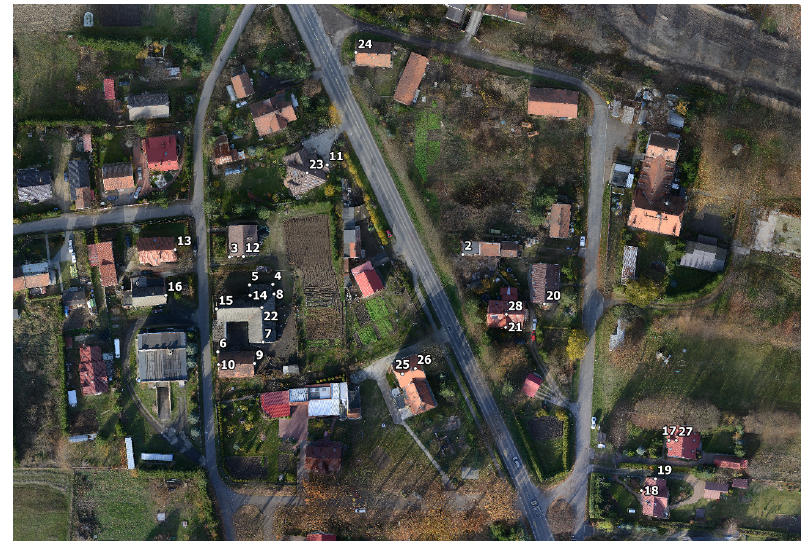
Fig 2.1: An overview of the study area. Orthophoto image with Check Points located on building roofs